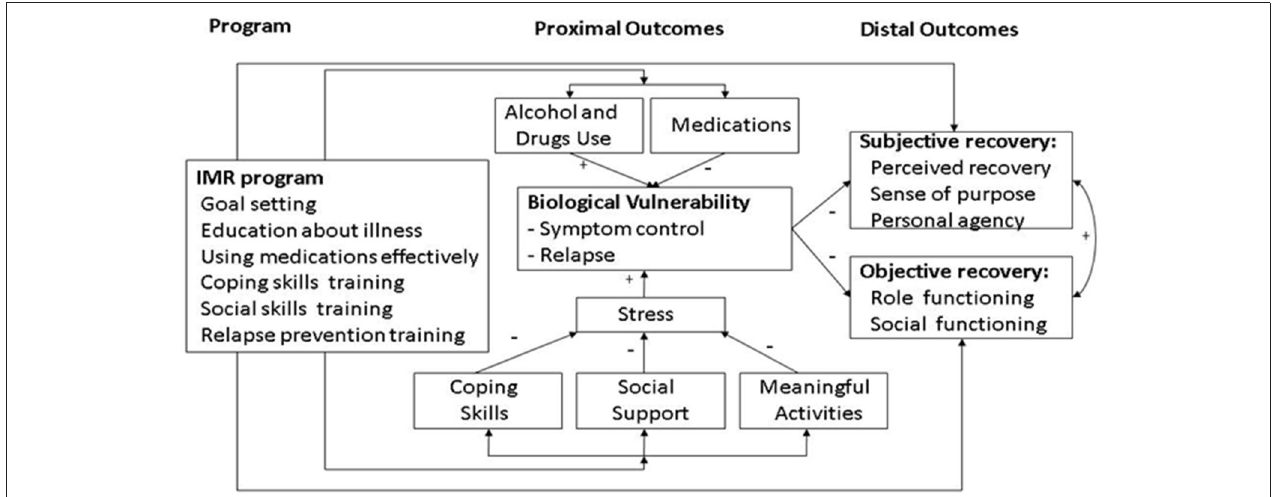
FIGURE 1 | Conceptual framework of illness management and recovery